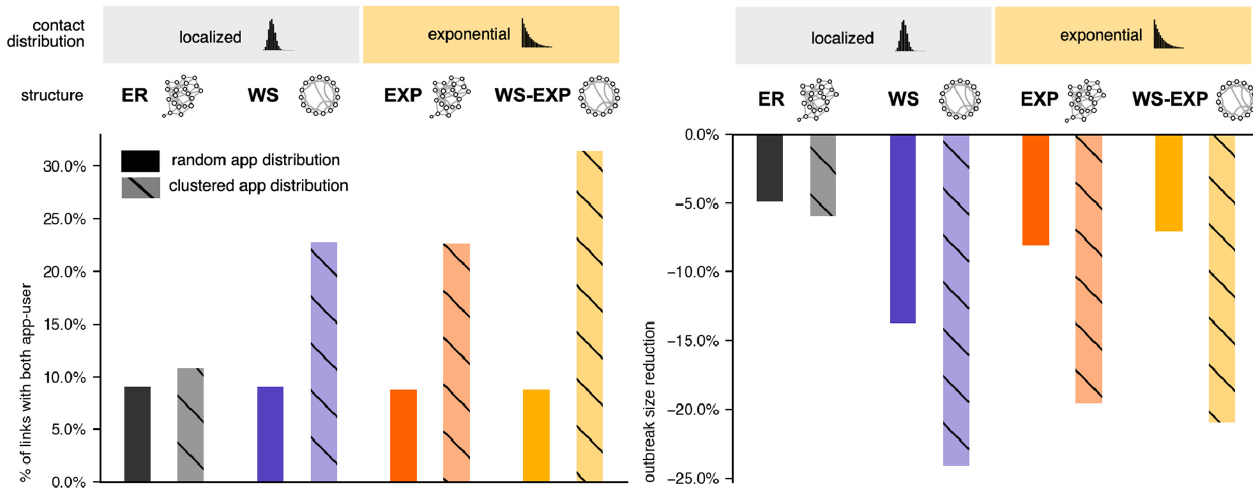
Fig 4. Percentage of links in the network with both nodes being app users (left) and relative outbreak size reduction caused by DCT with UA 0 = 4 ( q = 0.3) (right) in ER, WS, EXP, WS-EXP networks with an app participation of a = 30%.